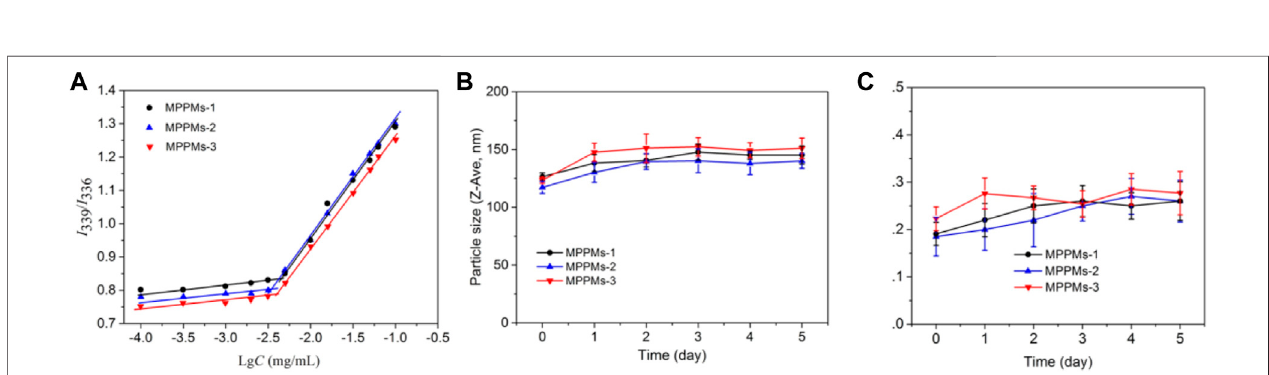
FIGURE 3 | Plot of intensity ratios I 339 / I 336 as a function of logarithm of polyprodrugs concentration at pH 7.4 (A) . Hydrodynamic diameter (B) and polydispersity index (PDI) (C) of MPPMs after incubation in PBS at pH 7.4 containing 20% FBS at 37 ° C for 5 days con fi rmed by DLS ( n = 3, mean ± SD).